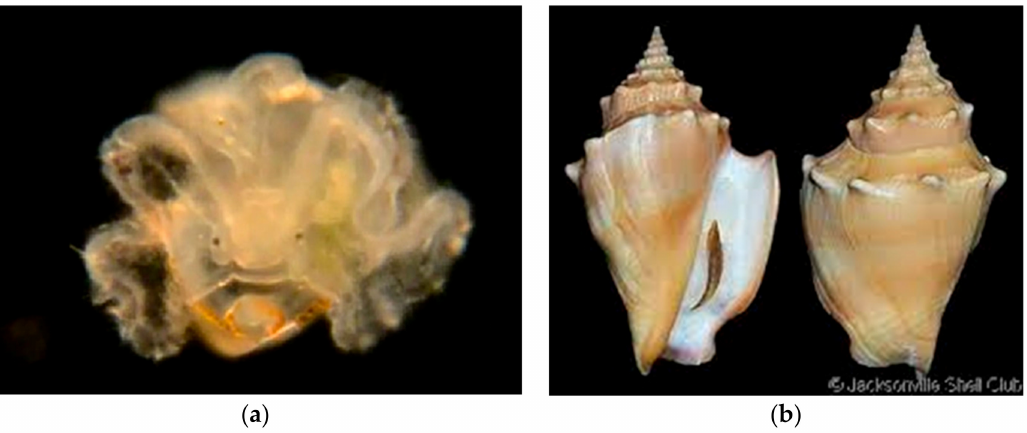
Figure 9. Family Strombidae. Eastern Pacific fighting conch , Strombus gracilior . ( a ) Veliger, CCDB- 24722-E09 from Bahia de Los Angeles, Baja California. ( b ) Adult, from Hardy’s Internet Guide to Marine Gastropods (This species is not recorded from Orange County).